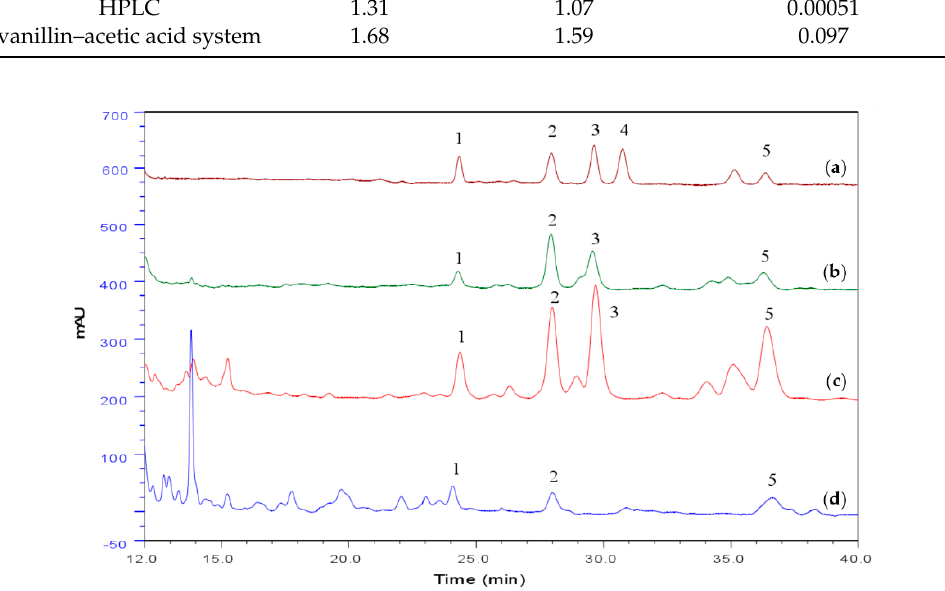
Figure 1. HPLC chromatogram of triterpenoids of A. camphorata in submerged culture, including the standard ( a ), mycelia ( b ), spore ( c ), and culture broth ( d ). 1: Ergosterol; 2: Cholesterol; 3: Lanosterol; 4: Stigmasterol; 5: Sitosterol.